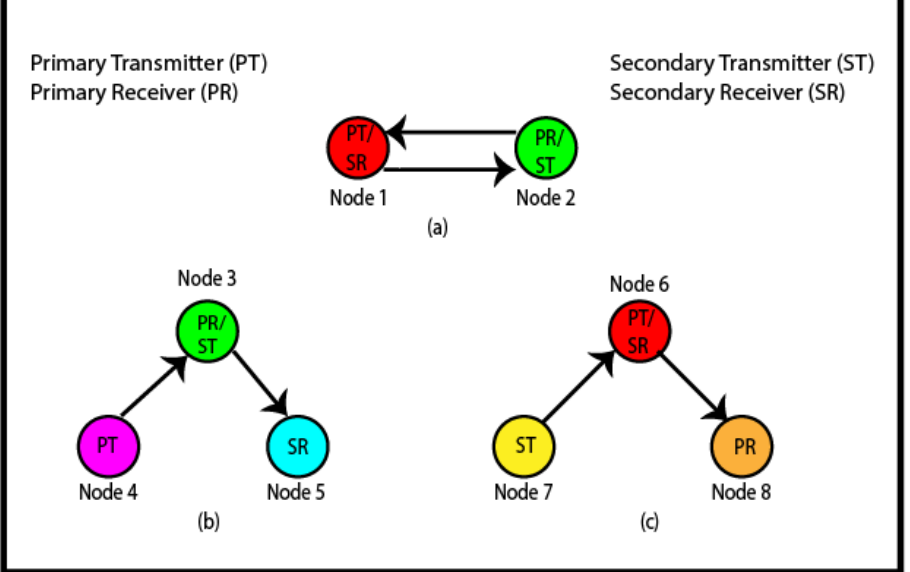
Figure 1. Different types of IBFD transmission: ( a ) BFD, ( b ) destination-based TNFD, ( c ) source- based